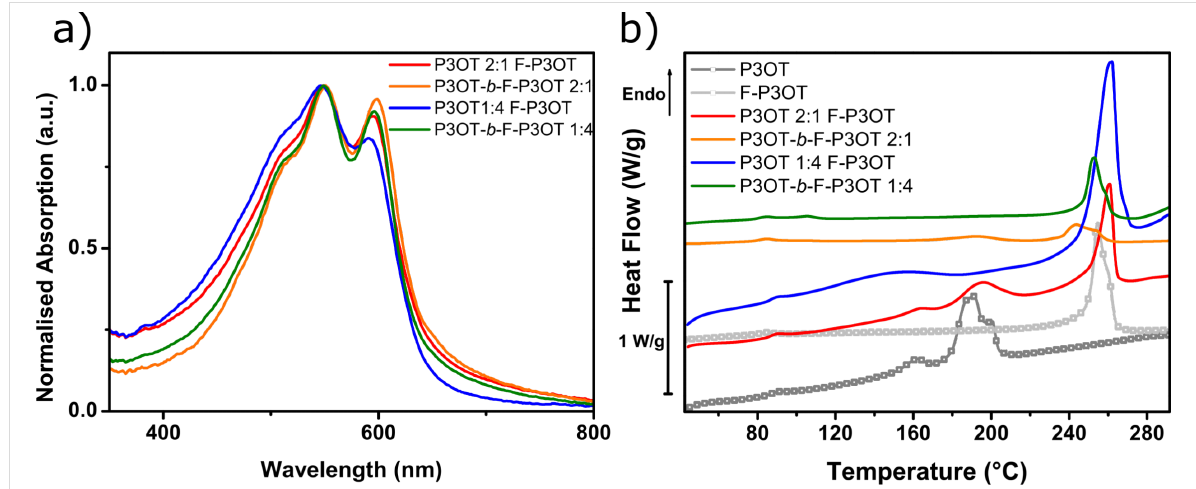
Figure 4: Overlay of thin film UV–visible absorption spectra (a) of the two block copolymers and the corresponding P3OT/F-P3OT blends. Thin films were spin cast from hot 1,2,4-trichlorobenzene. Differential scanning calorimetry thermograms (b) of dropcast films of the same samples. For compari- son, thermograms of P3OT and F-P3OT as dropcast films are also included. Only the heating curve (first cycle, 10 °C/min) is shown. Note that the peak observed at ca. 85 °C in all traces is an artefact resulting from the